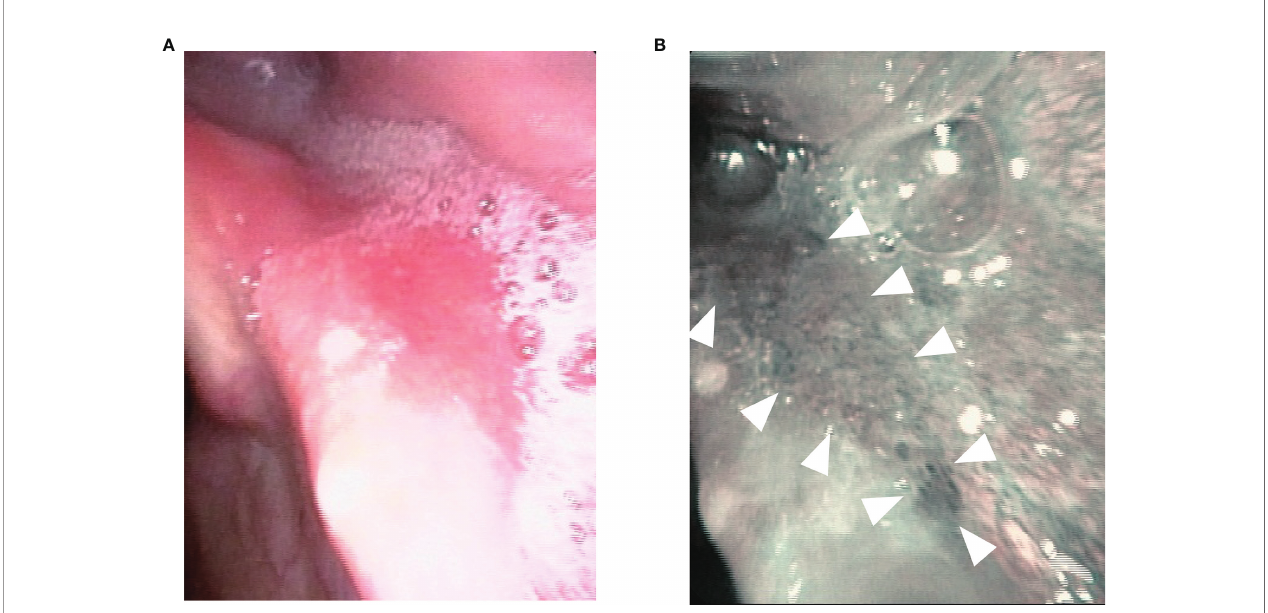
FIGURE 3 | Endoscopic imaging of a small submucosal lesion in the left piriform sinus. (A) The lesion was not clearly visualized with normal white light. (B) narrow band imaging enhanced a mucosal lesion with brownish area or scattered brown dots